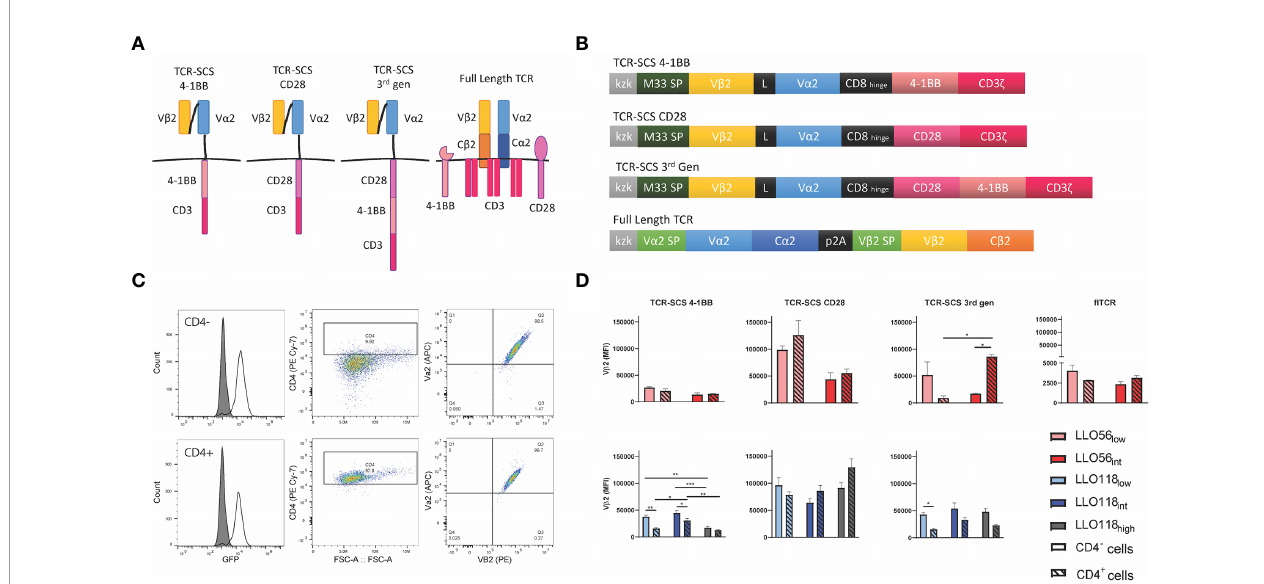
FIGURE 3 | TCR-SCS and fl TCRs are stably expressed in CD4 - and CD4 + T cell hybridomas. (A) Diagrams depicting the fl TCR formats and three TCR-SCS formats in the cell membrane. All TCR-SCS constructs have signaling coreceptor CD3 in addition to the signaling domains of coreceptors CD28 and/or 4-1BB. (B) TCR constructs are produced from a bicistronic IRES-GFP vector and GFP expression mirrors TCR construct expression in cell lines. In addition to the P2A cleavage domain, TCR-SCS formats rely on TCR M33 signal peptide (67), whereas the fl TCR has dedicated signal peptides for a 2 and b 2 to increase localization of both chains to the surface. The CD8 hinge acts as an intermembrane domain. (C) An example of TCR-SCS expression in CD4 - (top) and CD4 + (bottom) T cell hybridoma lines after magnetic column sorting with anti-V b 2 monoclonal antibodies (LLO118 high TCR-SCS CD28). Initial retroviral transfections ranged from 11 to 85% ef fi ciency. Grey peaks in GFP histograms represent a GFP - cells-only control. GFP + cells were gated for CD4 expression and V a 2 and V b 2 expression. Representative of n = 3 measurements of 20,000 cells via fl ow cytometry. (D) Mean fl uorescent intensity (MFI) of V b 2 was used as a proxy for stable expression of constructs. Constructs were expressed in CD4 - (solid bars) and CD4 + (hatched bars) T cell hybridomas. Representative of n = 3 measurements of 20,000 cells via fl ow cytometry. *<0.05, **<0.01,